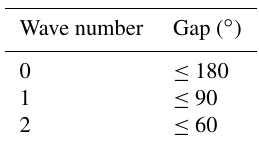
Table 2. The maximum allowable data gap determines the maxi- mum wave number used in the least squares